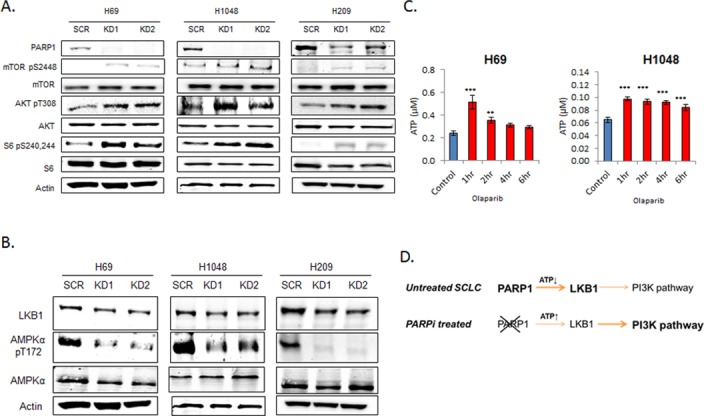
PARP inhibition inactivates the LKB1 pathway through increased ATP.(A) Lysates from PARP1 knockdown by shRNA in SCLC cell lines (H69, H1048, H209) results in increased activity of the PI3K/mTOR pathway relative to scramble (Scr) shRNA as determined by western blot. (B) PARP1 knockdown shRNA cells (KD1 and KD2) had lower LKB1 and pAMPKα expression than scramble shRNA cells. (C) H69 and H1048 cells treated with olaparib showed increased [ATP] as measured by ATPlite assay. Data are presented as mean ± SEM; ** p<0.02, *** p<0.01. (D) A proposed model of PI3K pathway activation following PARP inhibition.